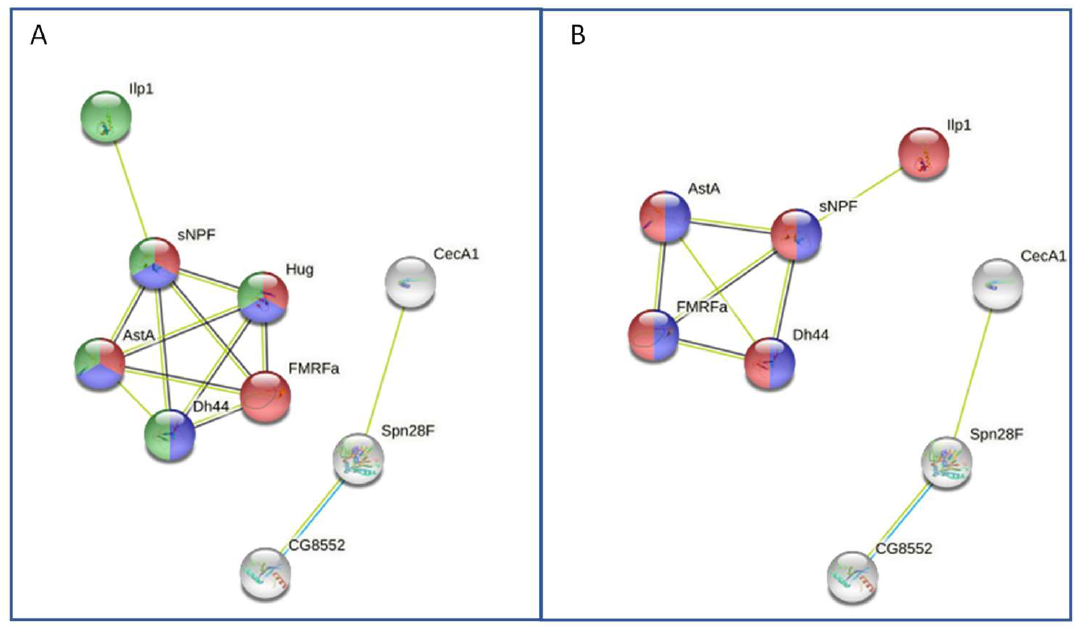
Figure 2. Protein–protein interaction network by STRING software version 11, https://string-db.org/ (panel ( A ), female; panel ( B ), male).